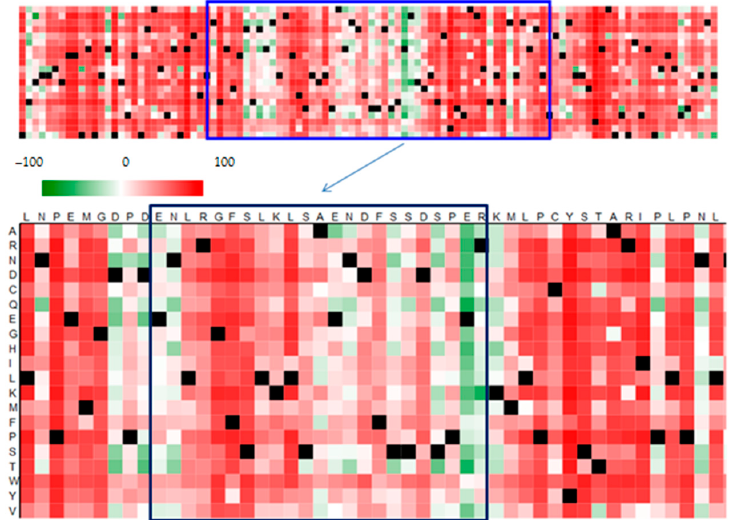
Figure 3. Prediction of functional effects of mutations in the amino acid sequence of the VP1 protein with a BC loop region (in frame) prepared in the SNAP2 application, showing polymorphic amino acids in relation to the DUN strain. Dark red indicates a high score (score > 50, strong signal for effect), white indicates weak signals ( − 50 < score < 50) and green a low score (score < − 50, strong signal for neutral/no effect). Black designates the corresponding wild-type residues. Own results.